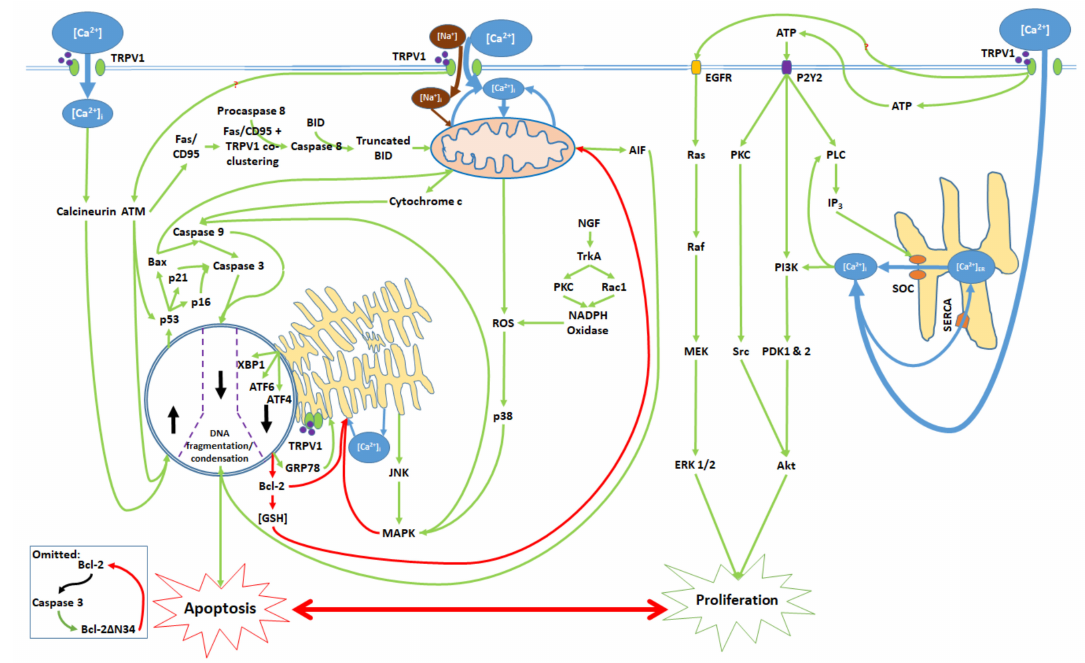
Figure 6. Activation of the TRPV1 ligand-gated ion channel and subsequent [Ca 2 + ] i and protein signaling influence the balance between proliferation and apoptosis. Mitochondrial dysfunction, ER stress, transcription factor activation, and nuclear activity promote caspase activation and the consequent DNA degradation, which are characteristic of apoptotic cell death. TRPV1 protein signaling upon activation induces the release of ATP, which binds to the P2Y2 receptor and activates a kinase signaling cascade, leading to ER Ca 2 + release and Akt activation. TRPV1 also activates EGFR and its associated protein signaling pathway, which upregulates ERK 1 / 2. Akt and ERK 1 / 2 contribute to cell proliferation. All cytosolic signaling pathways associated with the proliferative and apoptotic e ff ects of TRPV1 activation are